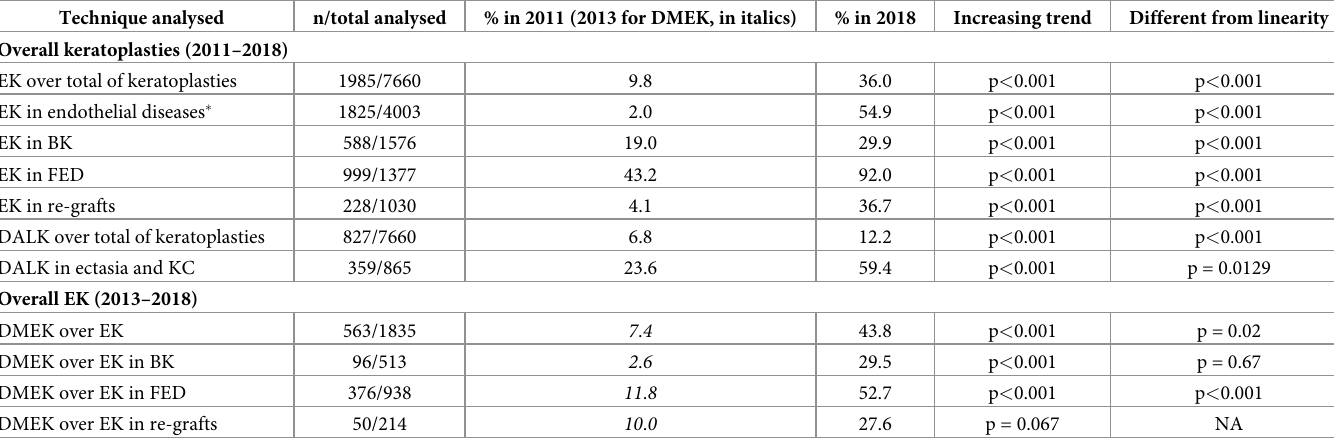
Table 2. Increasing trends of different techniques globally and for different pathologies (over total of keratoplasties with available information). Technique